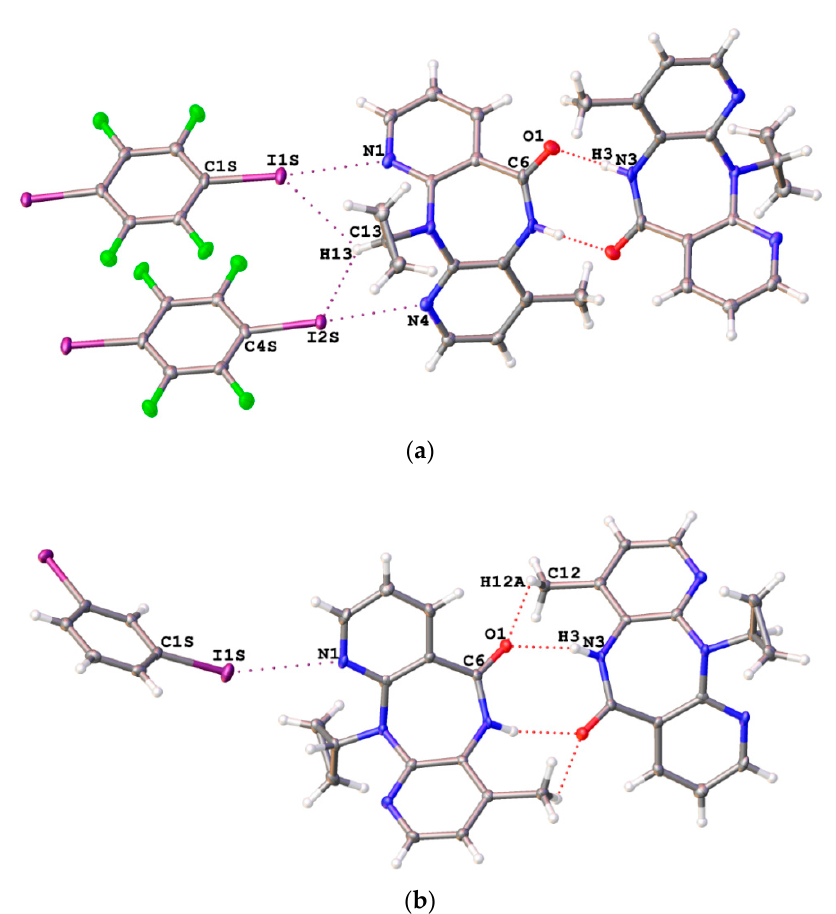
Figure 2. The important noncovalent interactions in NVP · 1,4-FIB ( a ) and NVP · 1,3-DIB ( b ) co-crystals obtained in this